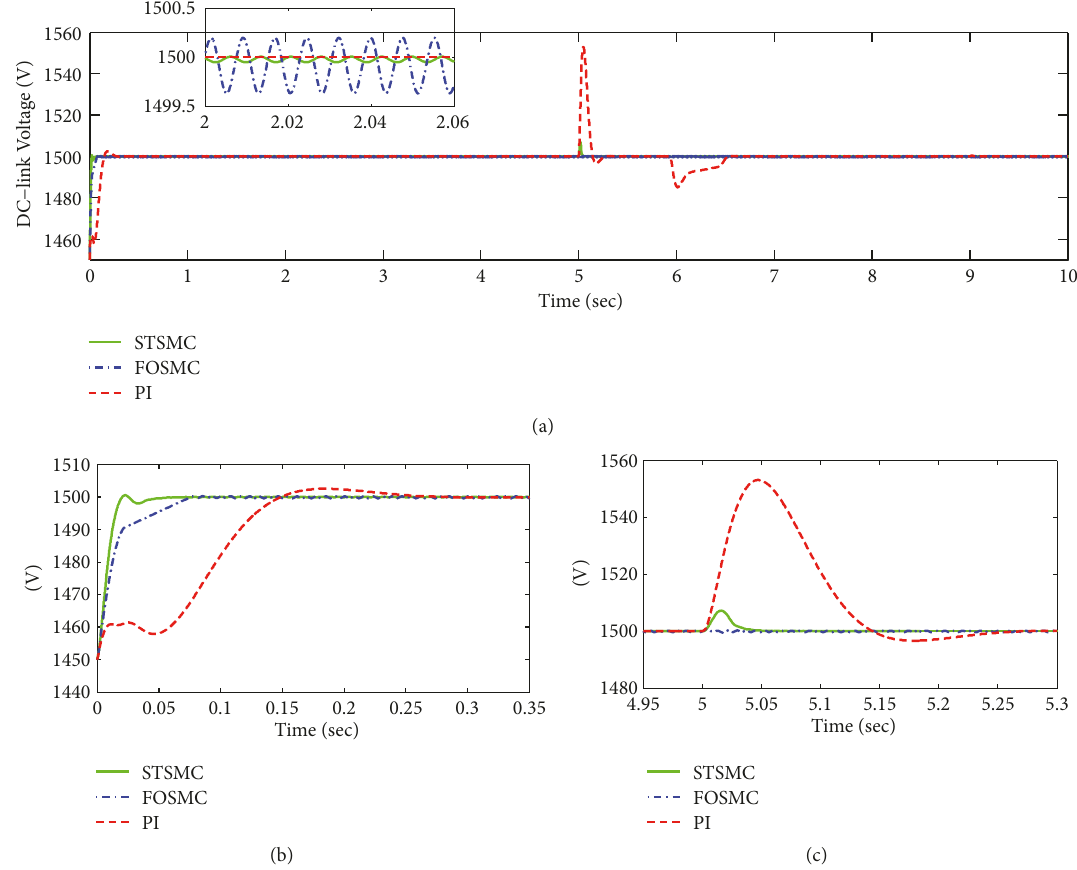
Figure 5: The DC-link voltage variation (a) with PI, FOSMC, and STSMC in the grid fault condition, (b) in starting time, and (c) in beginning time of grid voltage